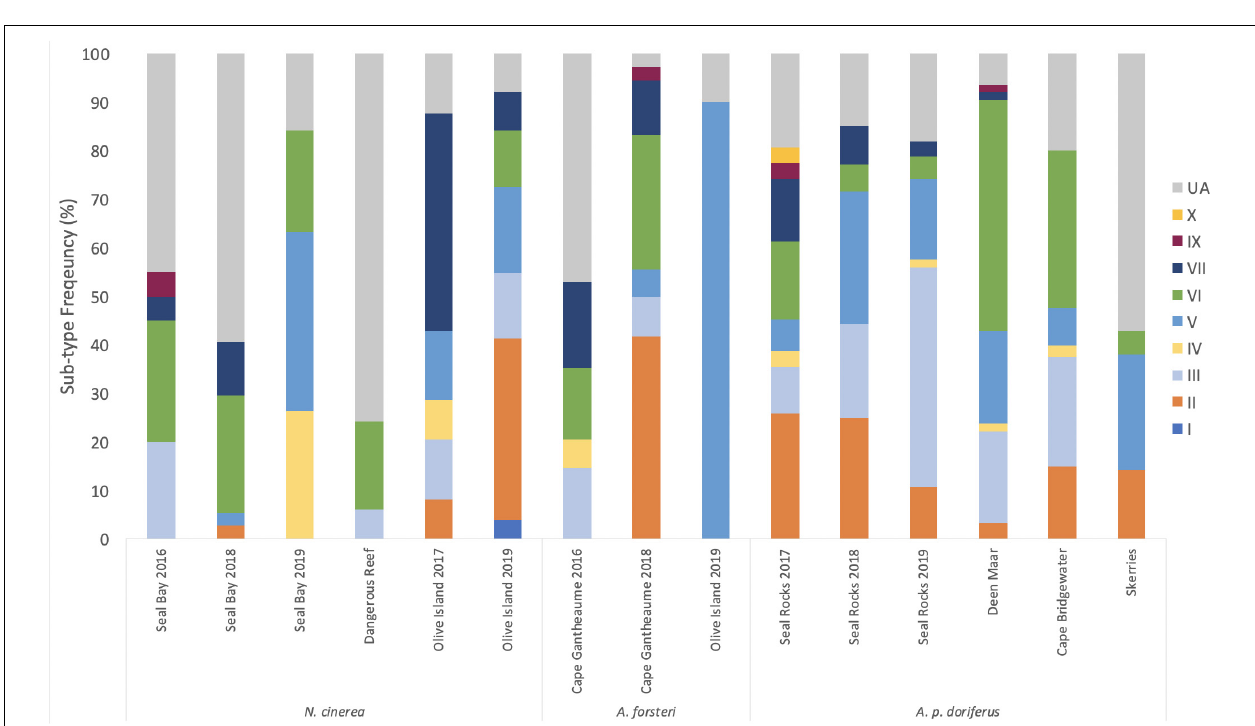
FIGURE 5 | Distribution of E. coli B2 sub-types for each breeding season in each species across the eight sampling sites. Samples that could not be assigned were classed as “unassigned” (UA). Sub-type I was only identified in N. cinerea and sub-group X was only detected in A. p. doriferus pups.